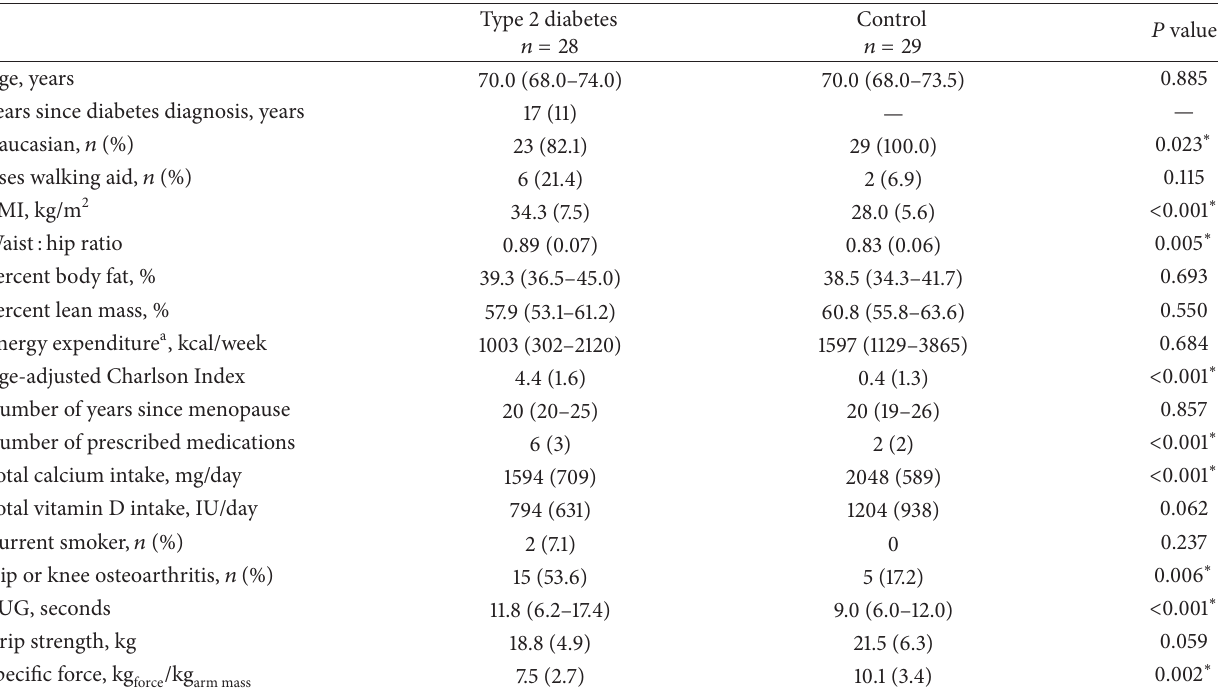
Table 1: Characteristics of study participants.